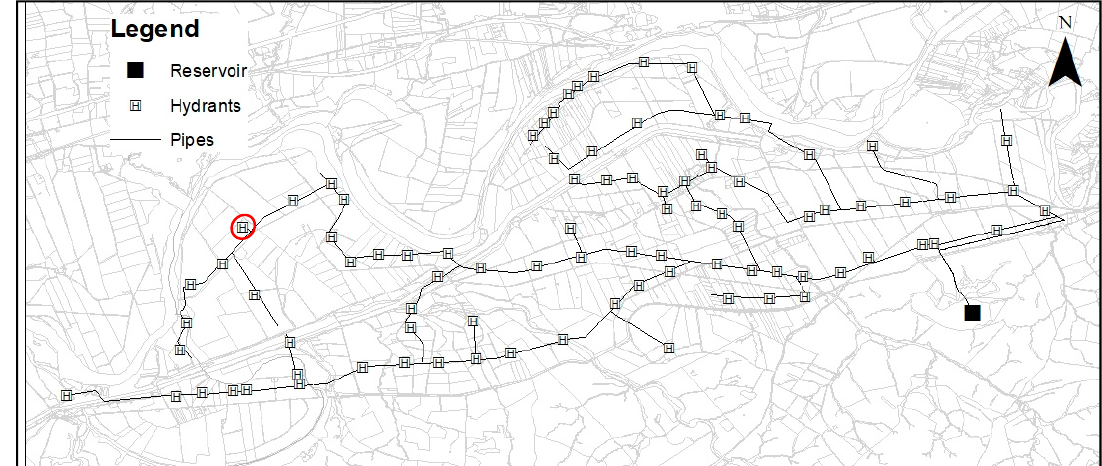
Figure 1. Hydrant and filter plant where the HPP will be installed.